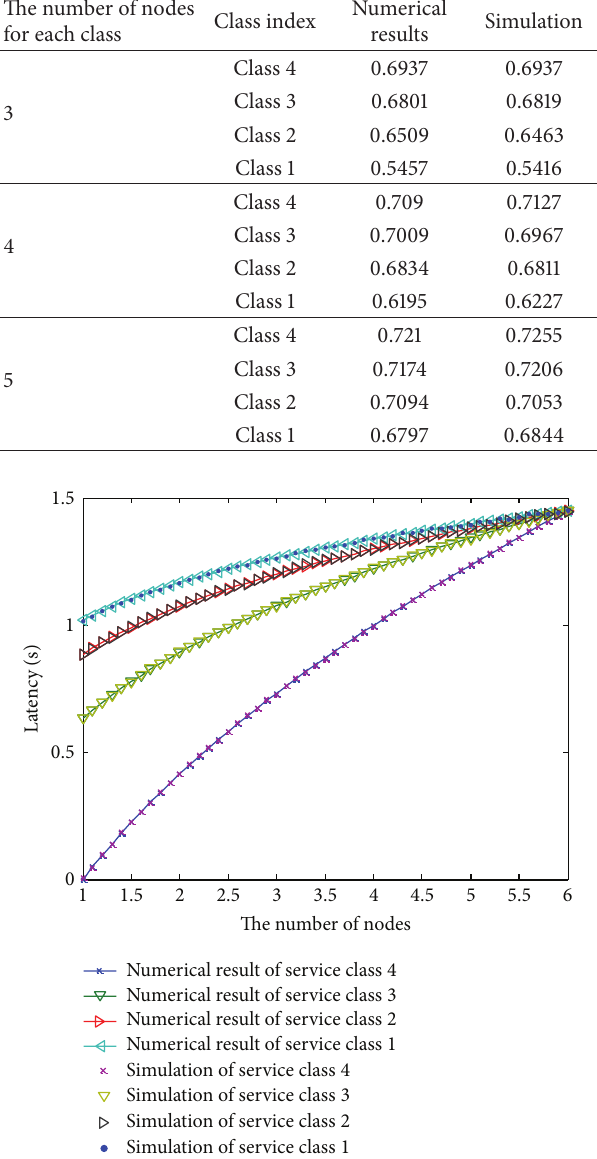
Figure 2: Latency result according to service classes.